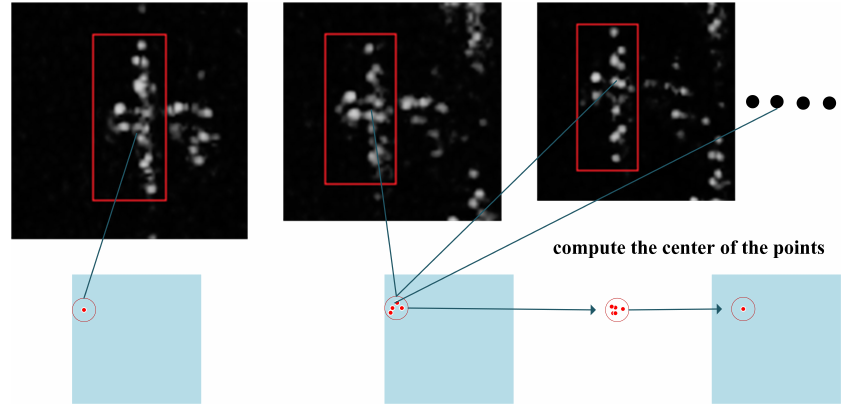
Figure 5. Determination of the anchor